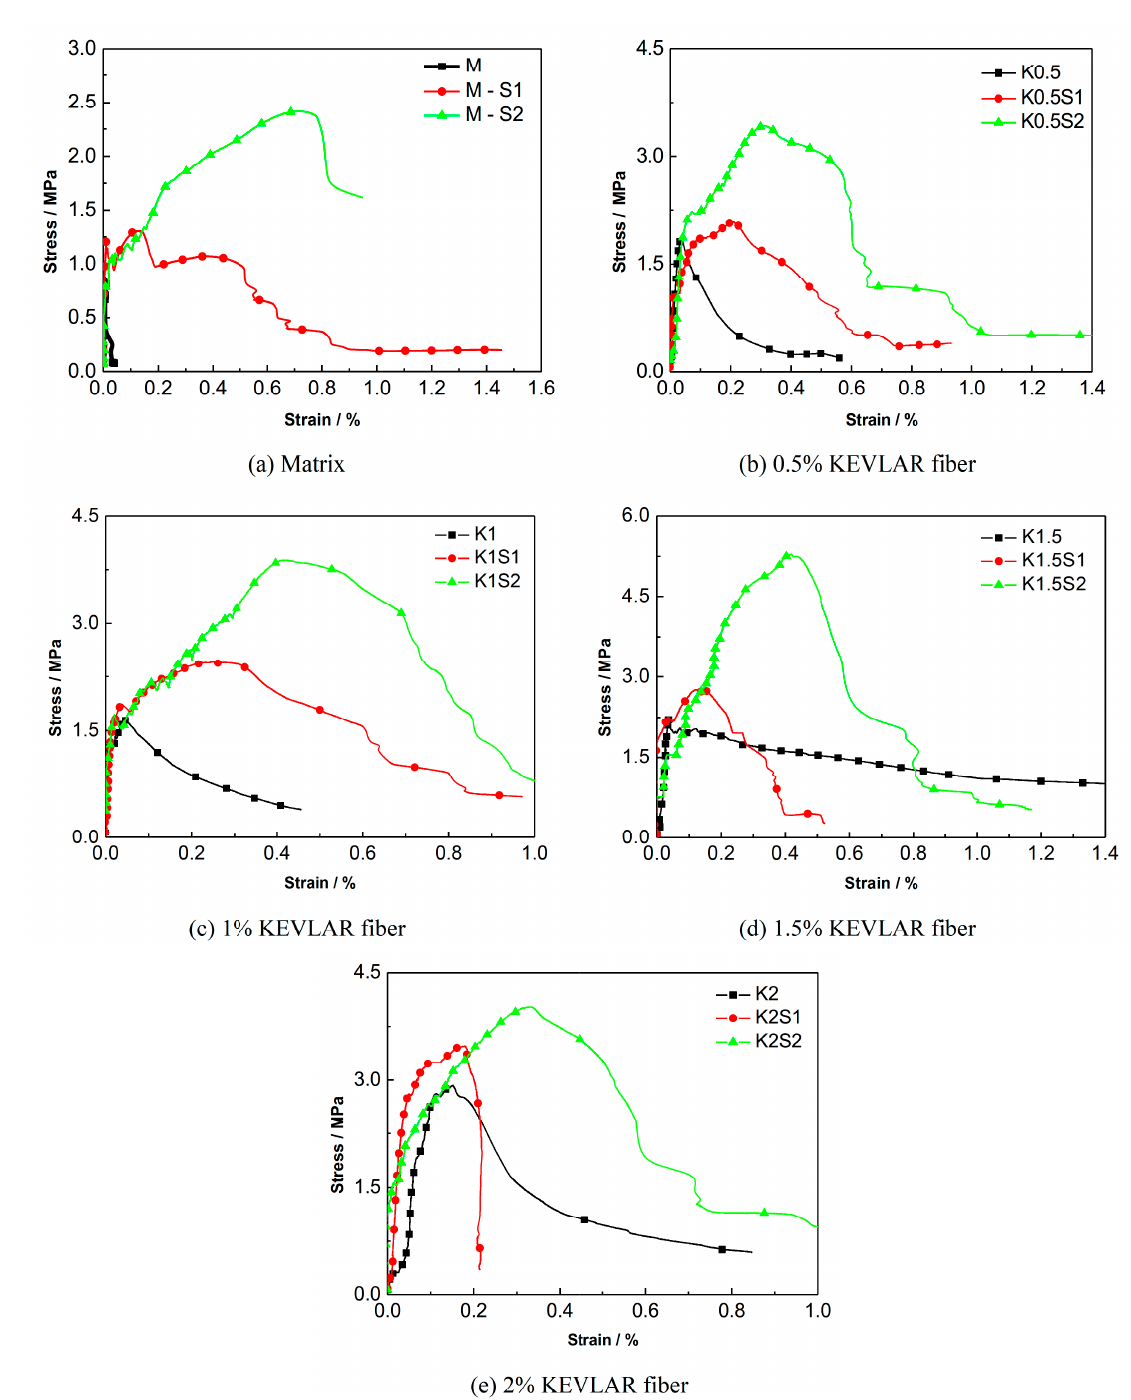
Figure 9. Comparison of stress-strain curves of ECC specimens with di ff erent numbers of steel-grid layers. ( a ) Matrix; ( b ) 0.5% KEVLAR fiber; ( c ) 1% KEVLAR fiber; ( d ) 1.5% KEVLAR fiber; ( e ) 2% KEVLAR